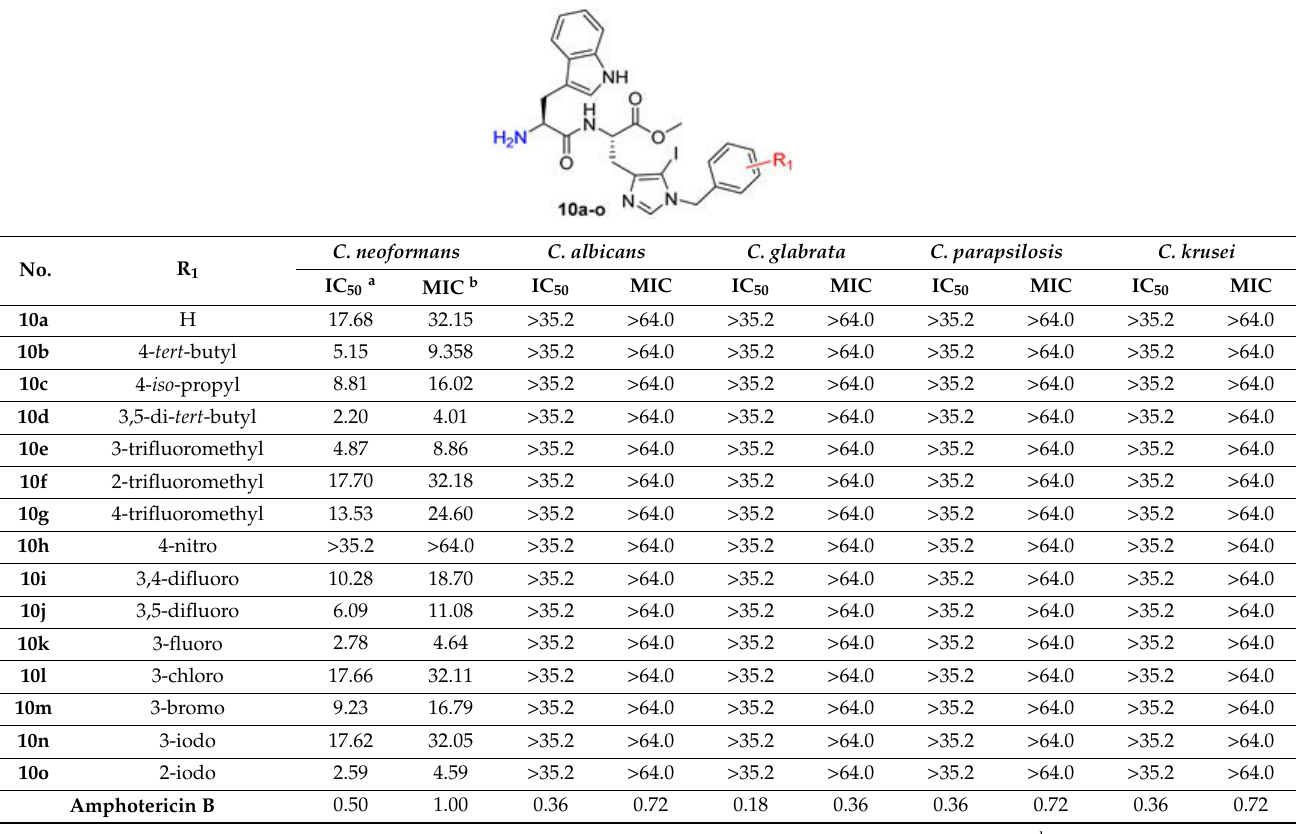
Table 2. In vitro antifungal screening of peptides (Series 2).